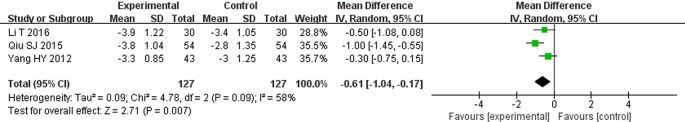
Meta-analysis for comparison of urinary transferrin levels between the experimental and control groups.